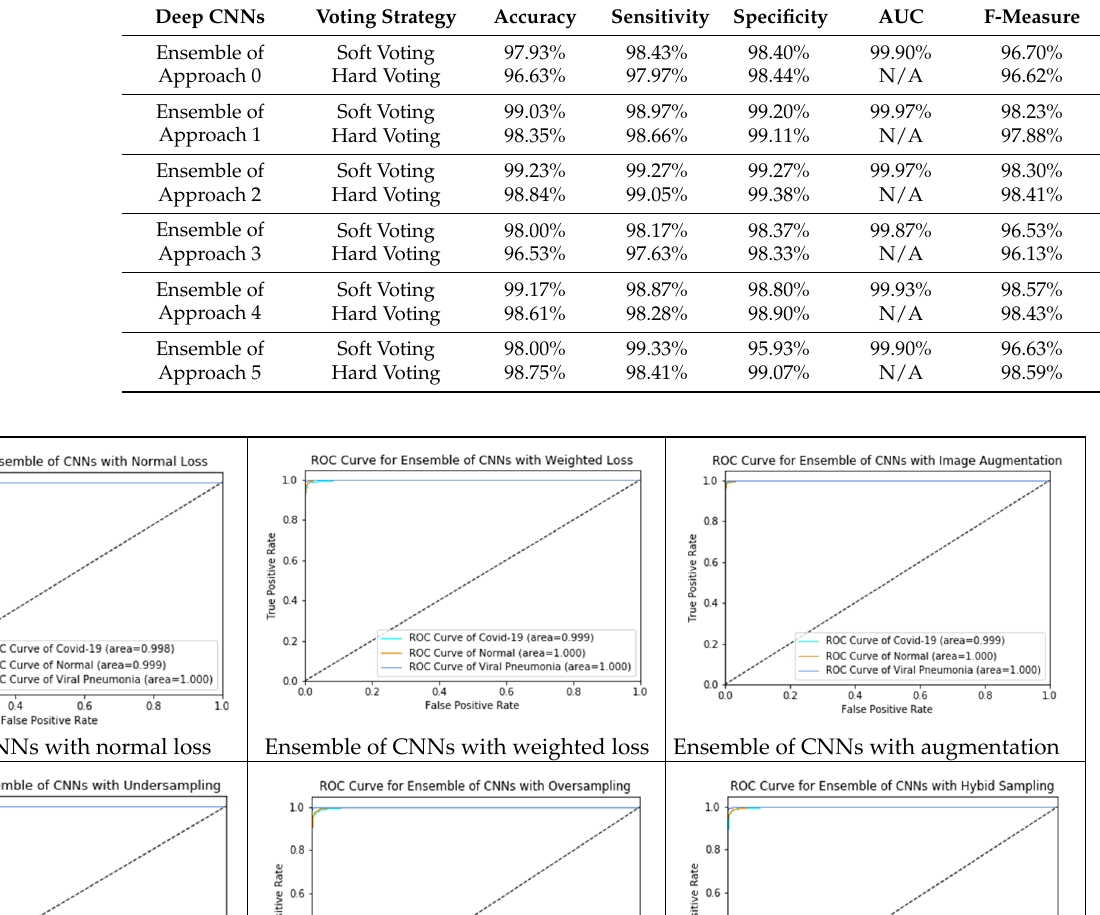
Table 10. Ensemble of top five models from each approach using majority soft voting and hard voting.